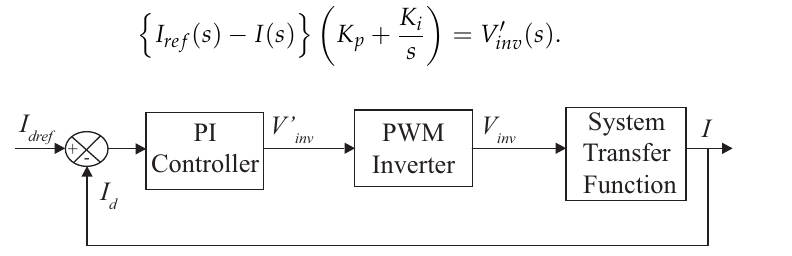
Figure 5. General block diagram for the inner current